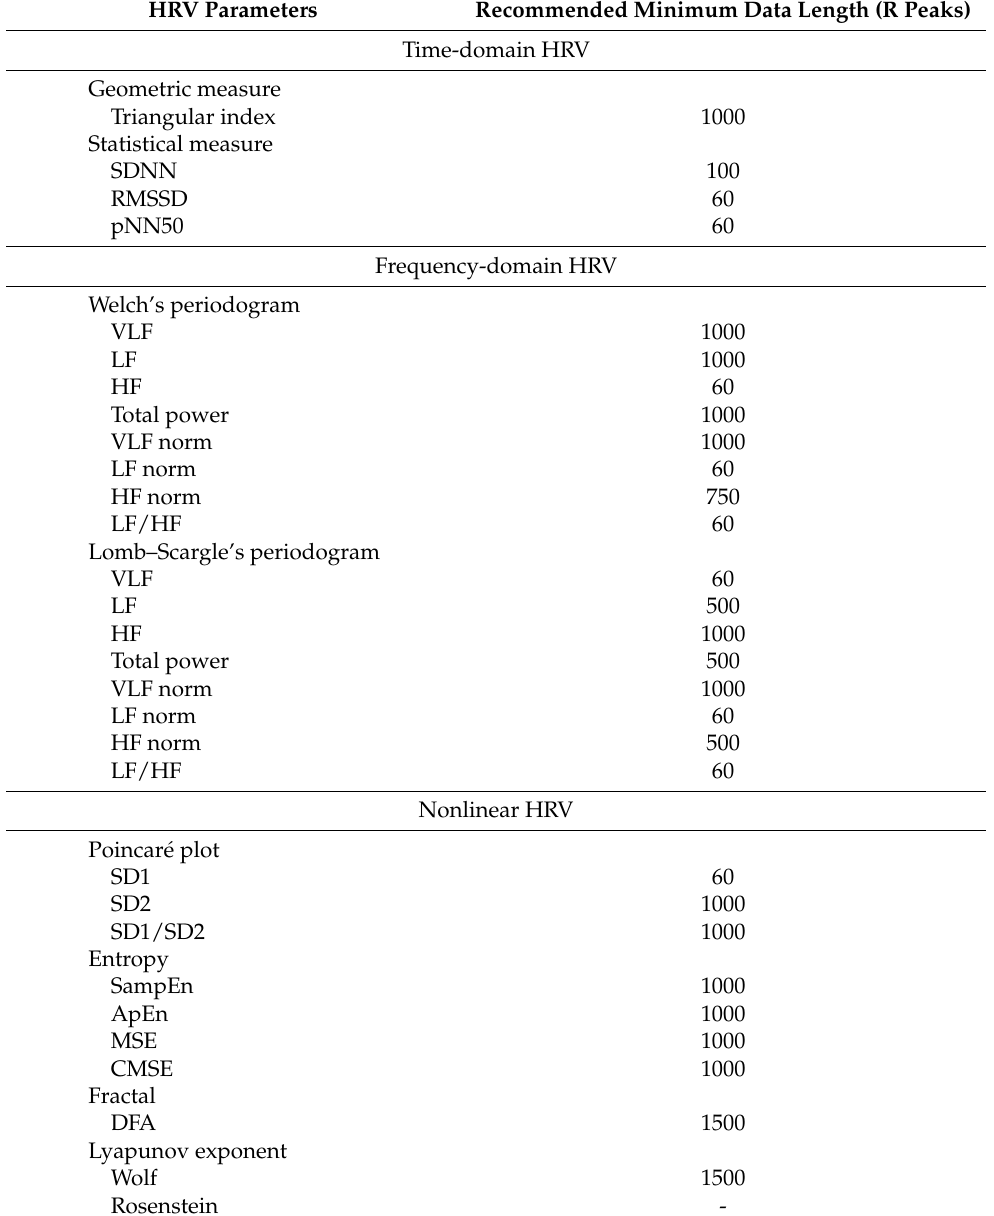
Table 4. The recommended minimum data length of each HRV